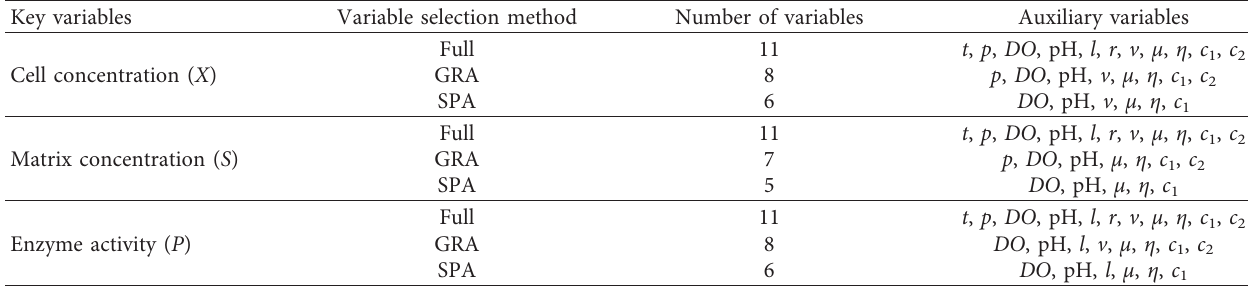
Table 2: Selection of auxiliary variables based on GRA and SPA